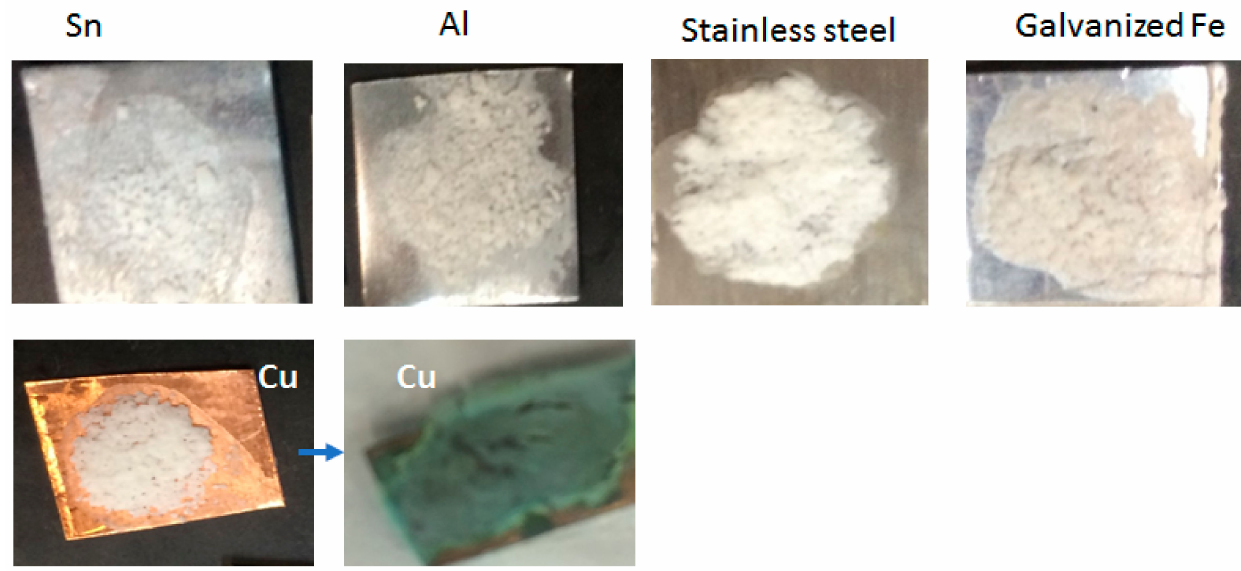
Figure 12. Photographs of the specimens used for the compatibility tests of Sn, Al, Stainless steel, Galvanized Fe, and Cu metal sheets coated with the P-10-MCC PCM sample. Under atmospheric conditions (at around 50 ◦ C, the lowest temperature around 10 ◦ C), only the P-10-MCC coated Cu specimen undergoes corrosion shown by change of its color after two